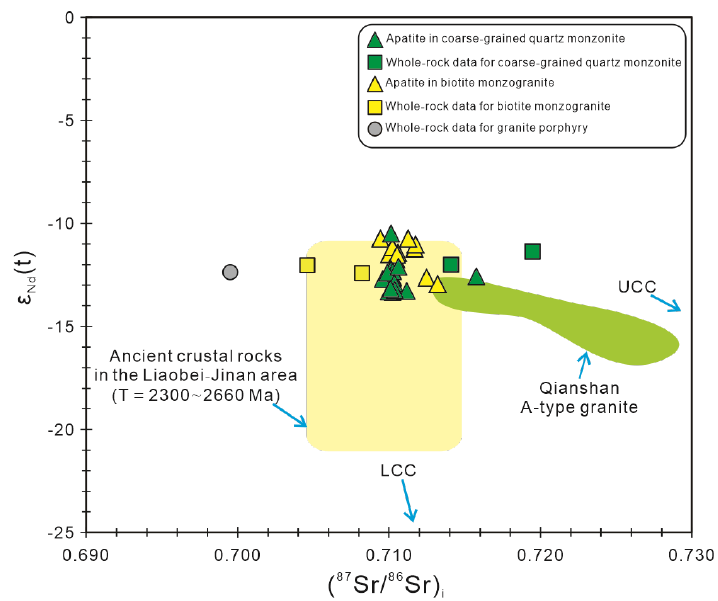
Figure 9. Plot of ε Nd (t) vs. ( 87 Sr/ 86 Sr) i for apatite grains extracted from the coarse-grained quartz monzonite and biotite monzogranite in the Yushulinzi pluton. The green and yellow squares and a gray circle represent the whole-rock Sr-Nd isotopic compositions of the coarse-grained quartz mon- zonite, biotite monzogranite, and granite porphyry, respectively. The data for the upper continental crust (UCC) and lower continental crust (LCC) are from [8,44,77]. The data for Qianshan A-type granites are quoted from Yang et al. [44]. The data for the ancient crustal rocks in the Liaobei-Jinan area are from [30,78,79].